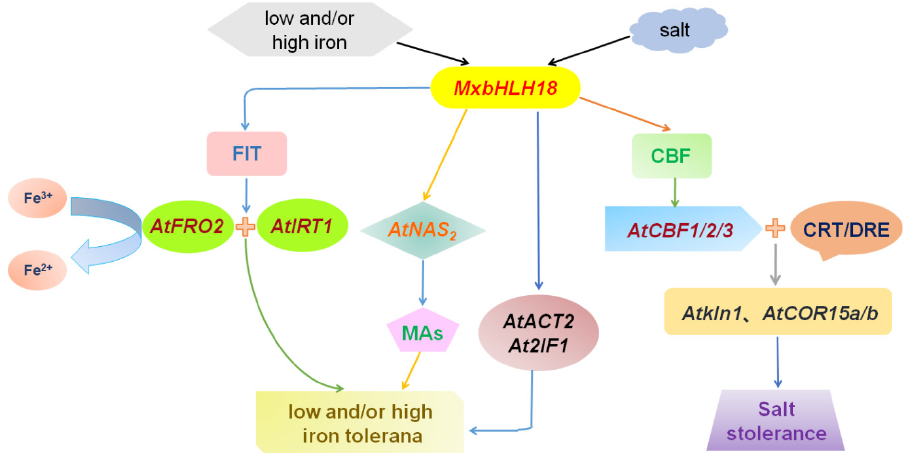
Figure 10. A possible model of MxbHLH18 response to high salt, low iron and high iron stress. Salt stress induced the expression of MxbHLH18 , which combined with CBF promoter. Thus, it can promote the expression of CBF1 , CBF2 and CBF3 and directly activate their expression by combining with the CRT/DRE cis-acting elements of the downstream salt stress response genes AtKIN1 , AtCOR15a and AtCOR15b which participate in the process of ABA synthesis and ABA signal transduction, so as to regulate the response of plants to salt stress. Due to the stimulation of low iron, MxbHLH18 gene is overexpressed, bHLH protein and FIT protein form heterodimer, which induces the up-regulated expression of AtFRO2 and AtIRT1 . AtFRO2 promotes the reduction of Fe 3+ adsorbed on the root epidermis to Fe 2+ . At the same time, the expression of AtNAS2 was up-regulated, which promoted the synthesis of MAs. In addition, the expression of other key iron stress response genes AtACT2 , AtZIF1 and AtOPT3 located downstream of MxbHLH18 was also up-regulated. When the signal of high iron stress is felt, the expression of these downstream genes is inhibited, which reduces the absorption and transportation of Fe 2+ by plant cells, so as to maintain the balance of Fe 2+ in cells, thereby improving the tolerance of plants to iron